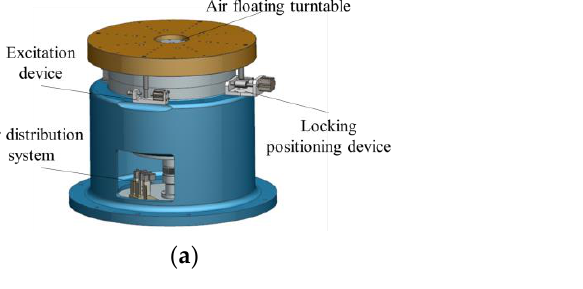
Figure 12. Model of lifting drive assembly. ⚫